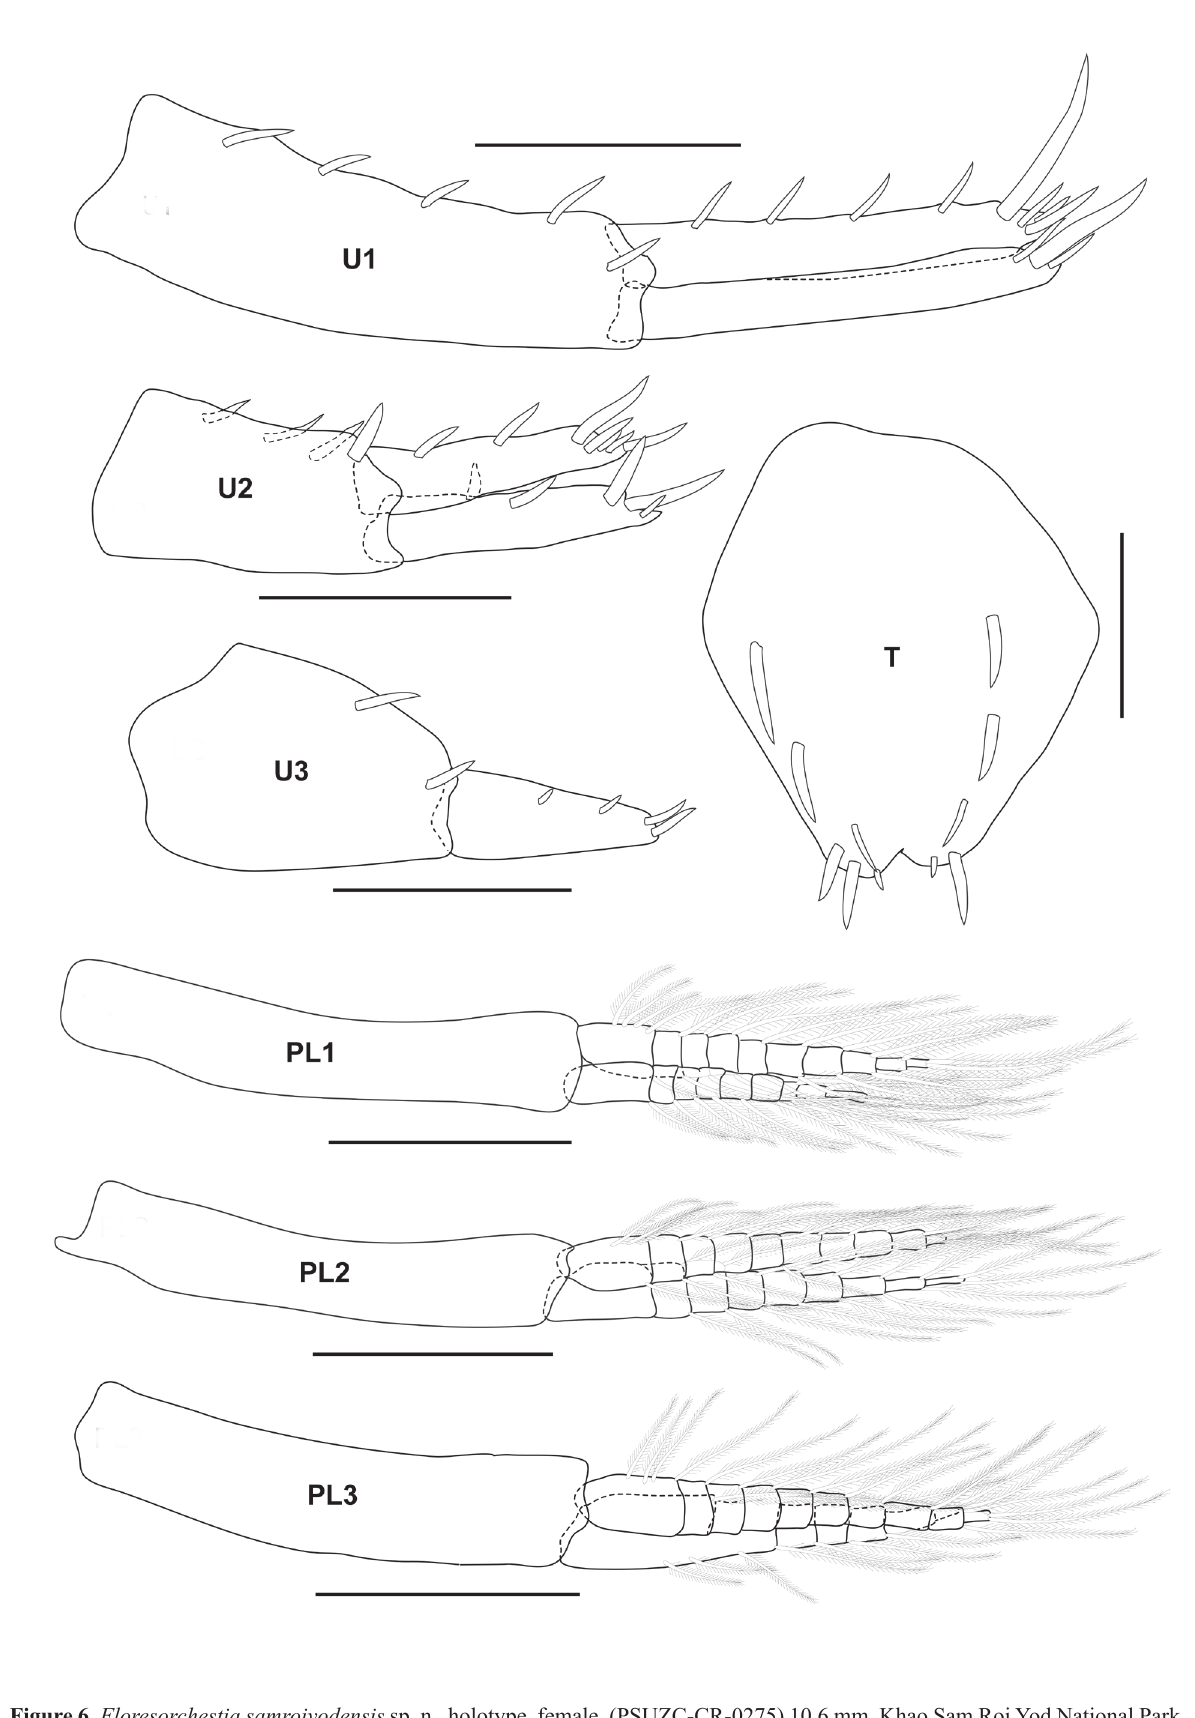
Figure 6. Floresorchestia samroiyodensis sp. n., holotype, female, (PSUZC-CR-0275) 10.6 mm. Khao Sam Roi Yod National Park. Scales for U1, U2, PL1, PL2 and PL3 represent; 0.5 mm, U3 and T represent 0.2